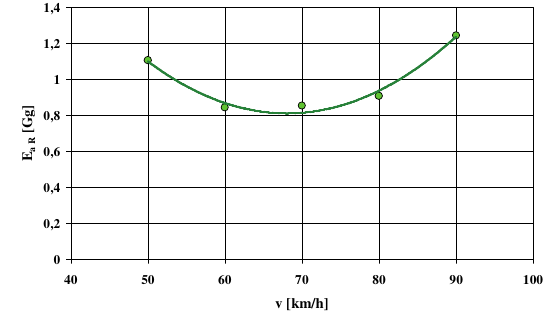
Fig. 17. Dependence of the national annual emission of particulate matter from the exhaust system of passenger car engines upon the average velocity, under model conditions of rural traffic